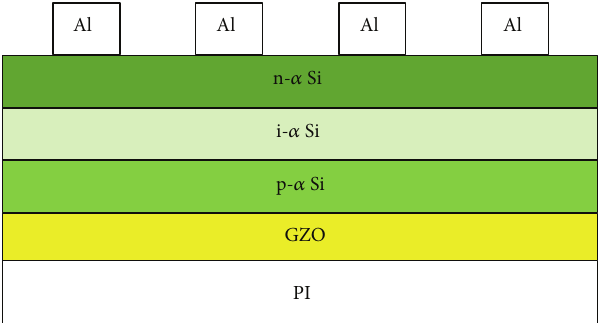
Figure 6: Carrier mobility, carrier concentration, and resistivity of the GZO thin films as a function of substrate temperature.